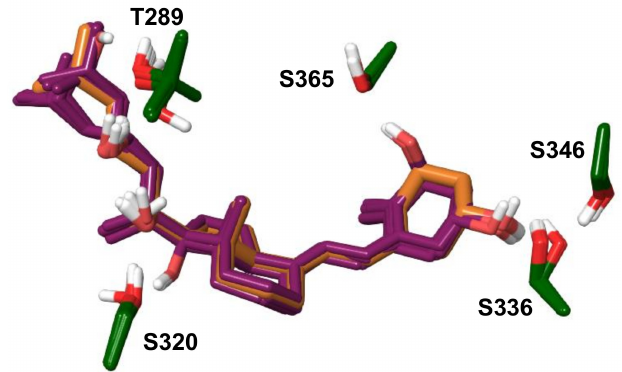
Figure 9. Induced Fit docked vitamin D3 analogs displayed simultaneously. The pose of 20 S ,23 S (OH) 2 D3 from the refined AhR model is shown for comparison, with carbon atoms colored light brown. Only AhR residues involved in polar interactions are